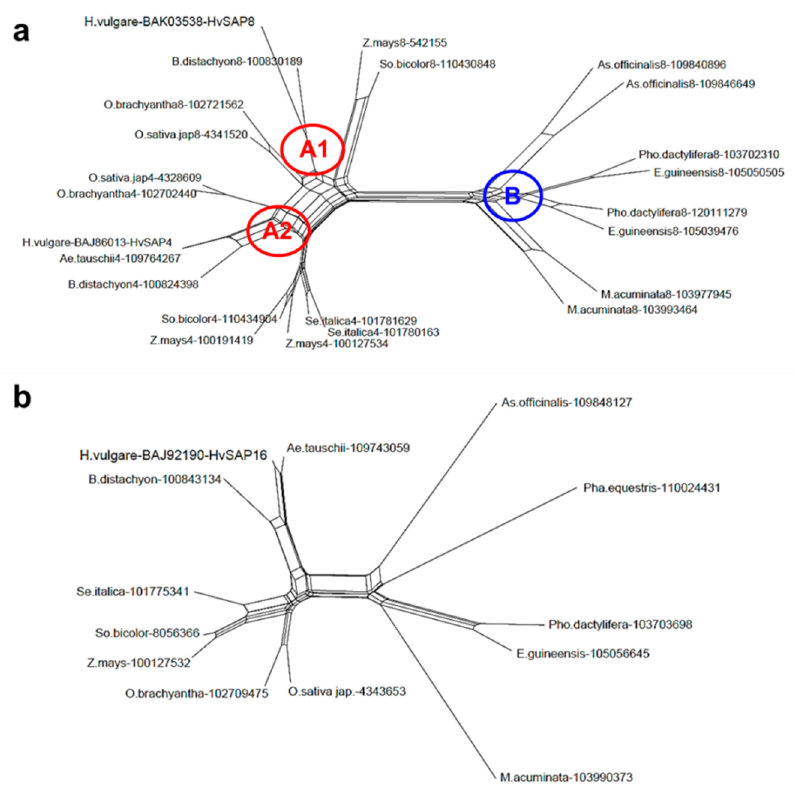
Figure 1. Molecular phylogenetic dendrogram based on amino acid sequences of proteins SAP8 and SAP4 ( a ), and SAP16 ( b ) among monocot species. Sub-clades A1 and A2 designate SAP8 and SAP4 peptides among cereals, and Clade B shows other monocots. Barley HvSAP protein accession IDs were retrieved from the NCBI database and all homologous protein sequences from other monocot plant species were identified in KEGG (Kyoto Encyclopedia of Genes and Genomes). The botanical names of the presented species are as follows, in anti-clockwise order as in the panel ( a ) with the addition of panel ( b ): Clade A: Sorghum bicolor , Zea mays, Brachypodium distachyon , Hordeum vulgare , Oryza brachyantha , Oryza sativa ssp. japonica , Aegilops tauschii , and Setaria italica ; Clade B: Musa acuminata , Elaeis guineensis , Phoenix dactylifera , Phalaenopsis equestris , and Asparagus officinalis . The corresponding protein sequence accession IDs were added after the species names. The unrooted Consensus tree with Equal angle dendrogram was generated by the program SplitsTree4 (http://www.splitstree.org) (accessed on 18 June 2021). The second gene, HvSAP16 (MLOC_52196), located on chromosome 2H, represents a relatively rare group encoding a Zinc-finger protein (BAJ92190 = AK360983) with AN1